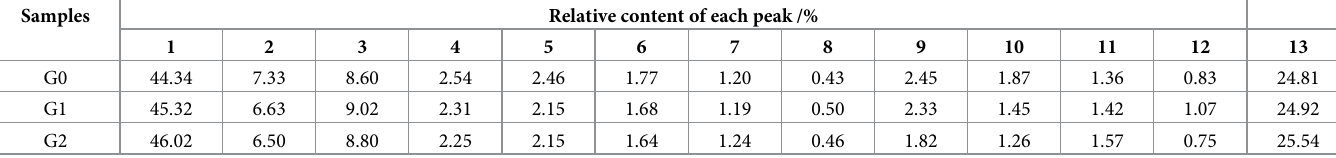
Table 7. Fitting results of infrared spectra of straw. Samples Relative content of each peak